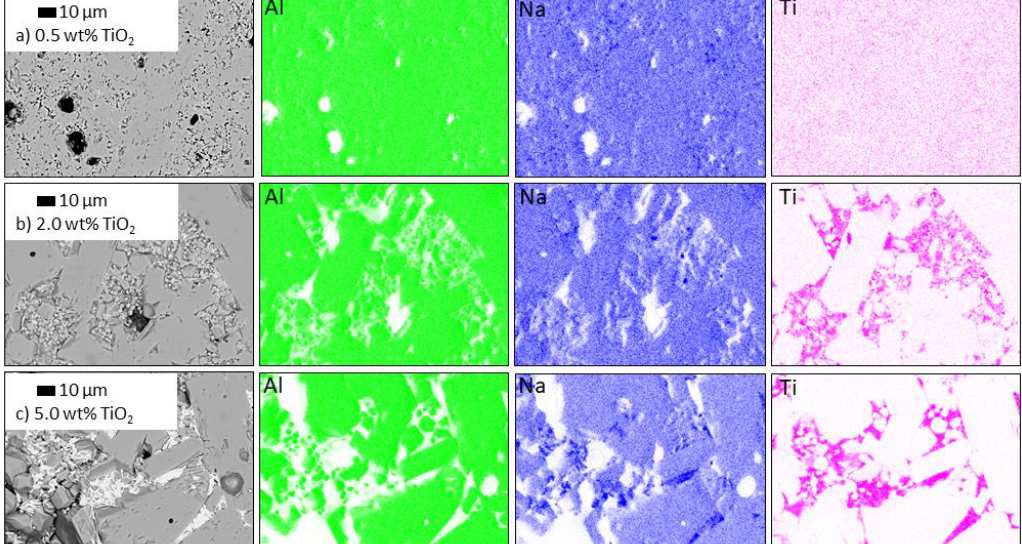
Figure 8. SEM images of Na- β″ -alumina samples doped with different amounts of TiO 2 ( b – f ) in comparison to an undoped sample ( a ). The images were rearranged and reprinted with permission from Dirksen et al. [13].